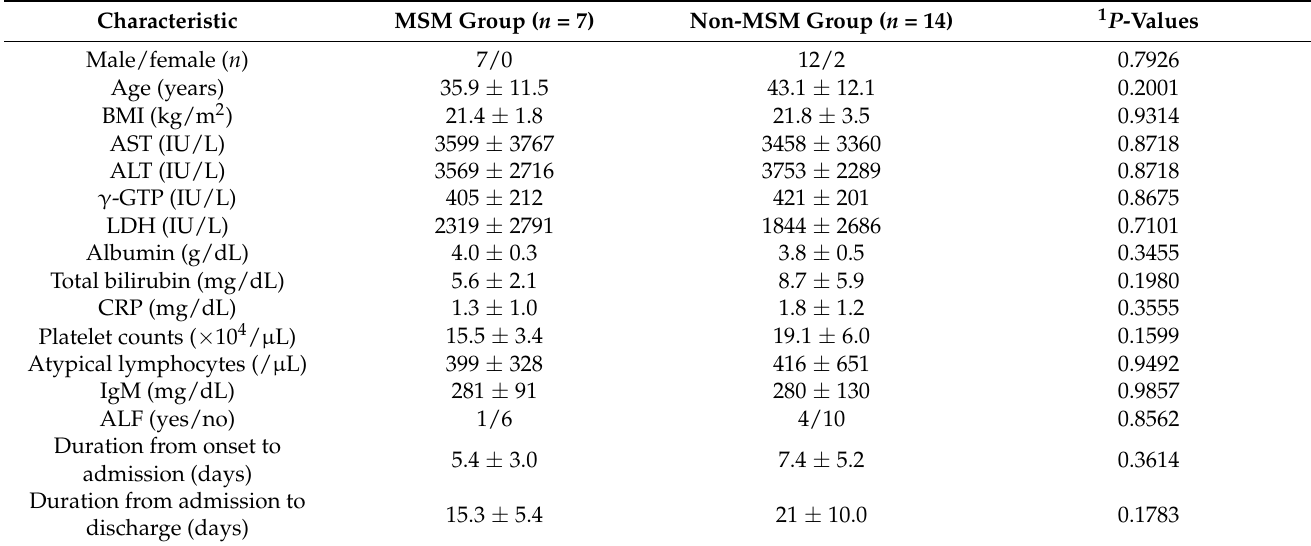
Table 3. Clinical characteristics of men who have sex with men (MSM) and non-MSM groups of patients at the baseline in the present study.